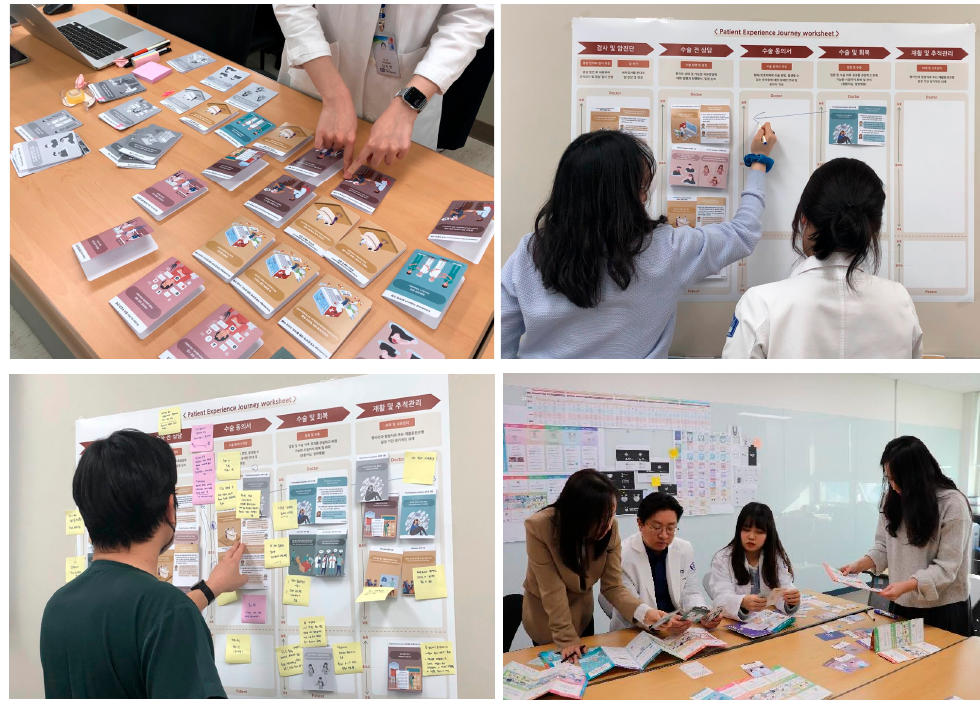
Figure 3. Co-creation workshop to improve HNC PE.